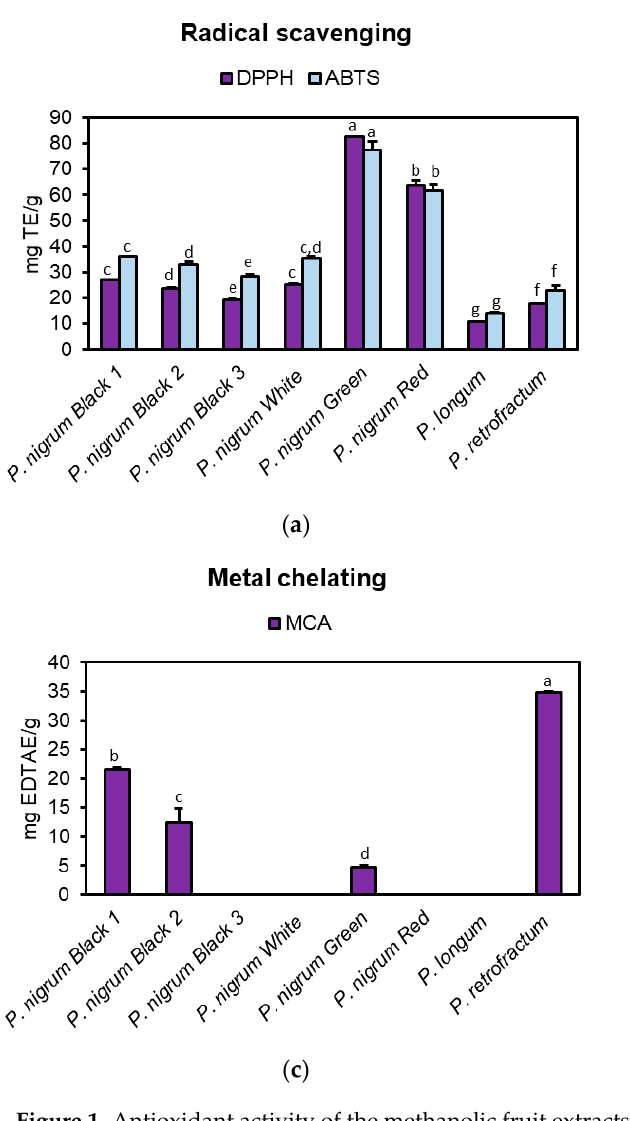
Figure 1. Antioxidant activity of the methanolic fruit extracts obtained from different spices of genus Piper in ( a ) radical scavenging, ( b ) metal reducing, ( c ) metal chelating and ( d ) total antioxidant assays. Data are presented as mg Trolox equivalents (TE)/g extract in 1,1-diphenyl-2-picrylhydrazyl (DPPH), 2,2 ′ -azino-bis(3-ethylbenzothiazoline) 6-sulfonic acid (ABTS) radical scavenging, cupric reducing antioxidant capacity (CUPRAC) and ferric reducing antioxidant power (FRAP) assays, mg EDTA equivalents (EDTAE)/g extract in metal chelating assay (MCA) and mmol TE/g extract in phosphomolybdenum (PBD) assay. Each bar represents mean ± S.D. of three determinations; samples sharing different superscript letters are significantly different at p < 0.05.